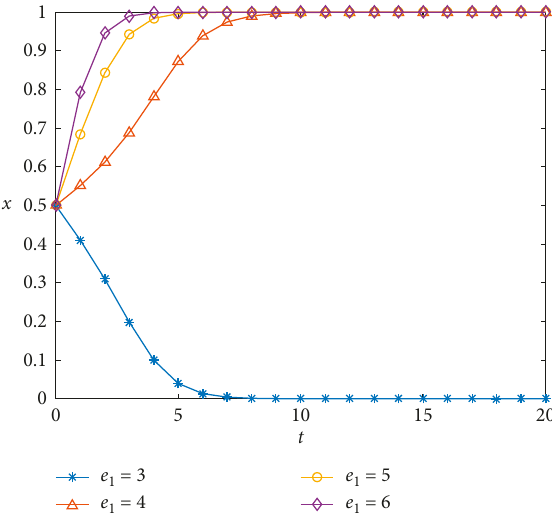
Figure 7: Influences of the quality-improving effort input e supplier.